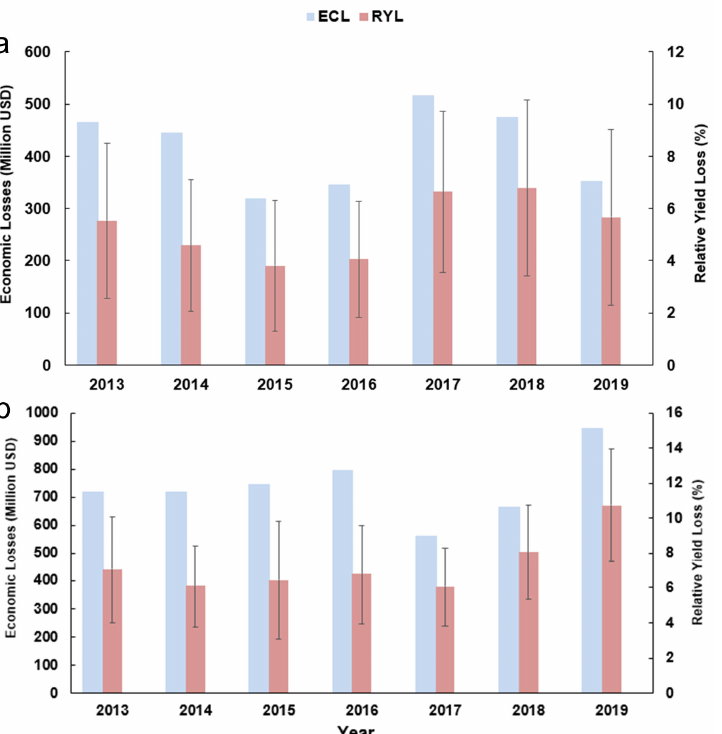
Figure 7. Economic loss and relative yield loss of double-season rice caused by ozone exposure in the whole of south China over 2013–2019. ( a ) Double-early rice and ( b ) double-late rice. The error bar indicates the standard deviation. Note that the ECL (economic cost loss, in Million USD) is a regionally summed indicator (not regionally averaged) and thus no error bars are applied.